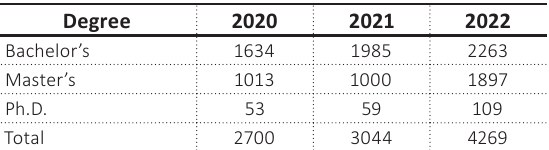
Table 1. Enrollment during the academic